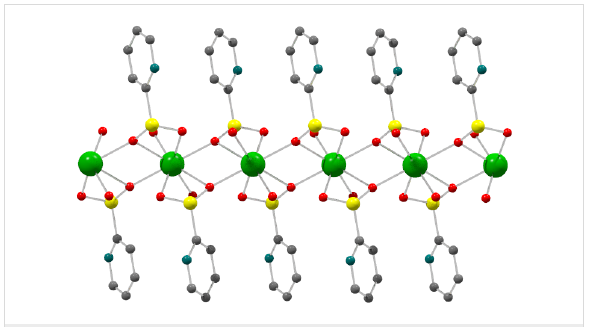
Figure 1: Model structure of the CaPhP layer. Calcium atoms are in green, phosphorus atoms in yellow and red and gray spheres corre- spond to oxygen and hydrogen,